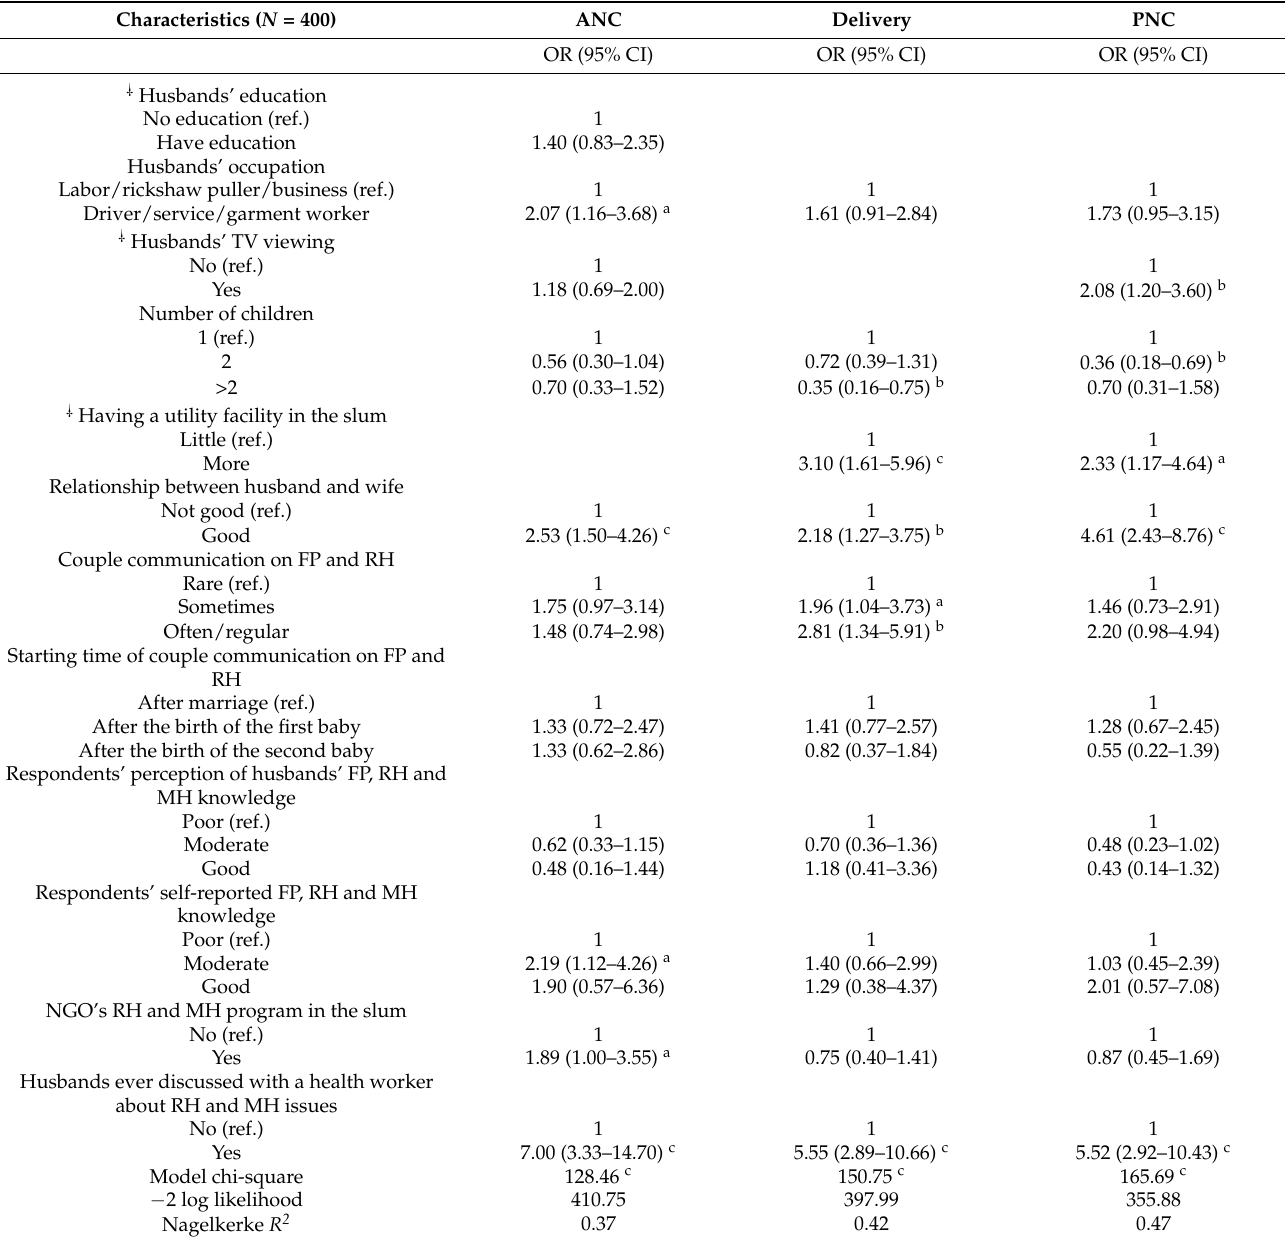
Table 4. Multivariate logistic regression predicting husbands’ involvement in wives’ ANC, childbirth and PNC. Characteristics ( N =